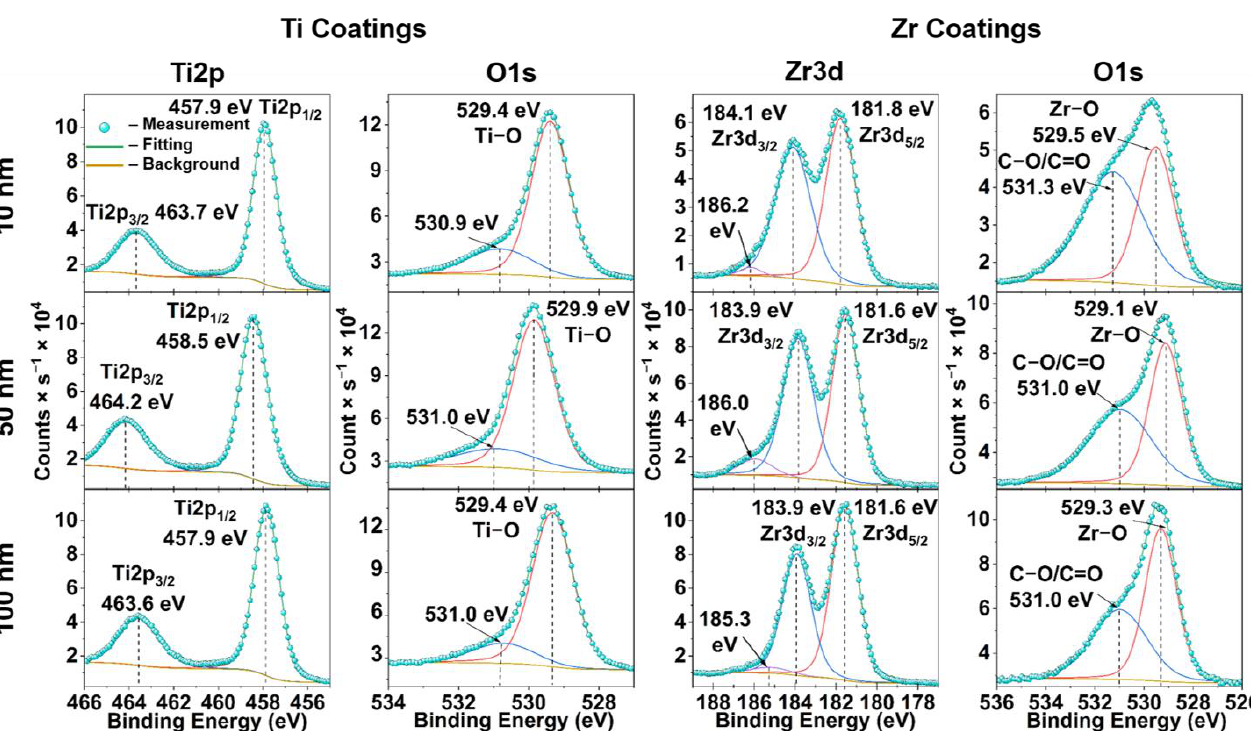
Figure 4. High-resolution XPS spectra of the obtained titanium (Ti) and zirconium (Zr) coatings with the thicknesses of 10 nm, 50 nm and 100 nm. Ti coatings are represented by Ti2p and O1s spectra; Zr3d and O1s spectra represent Zr coatings. Zr3d and O1s spectra represent Zr